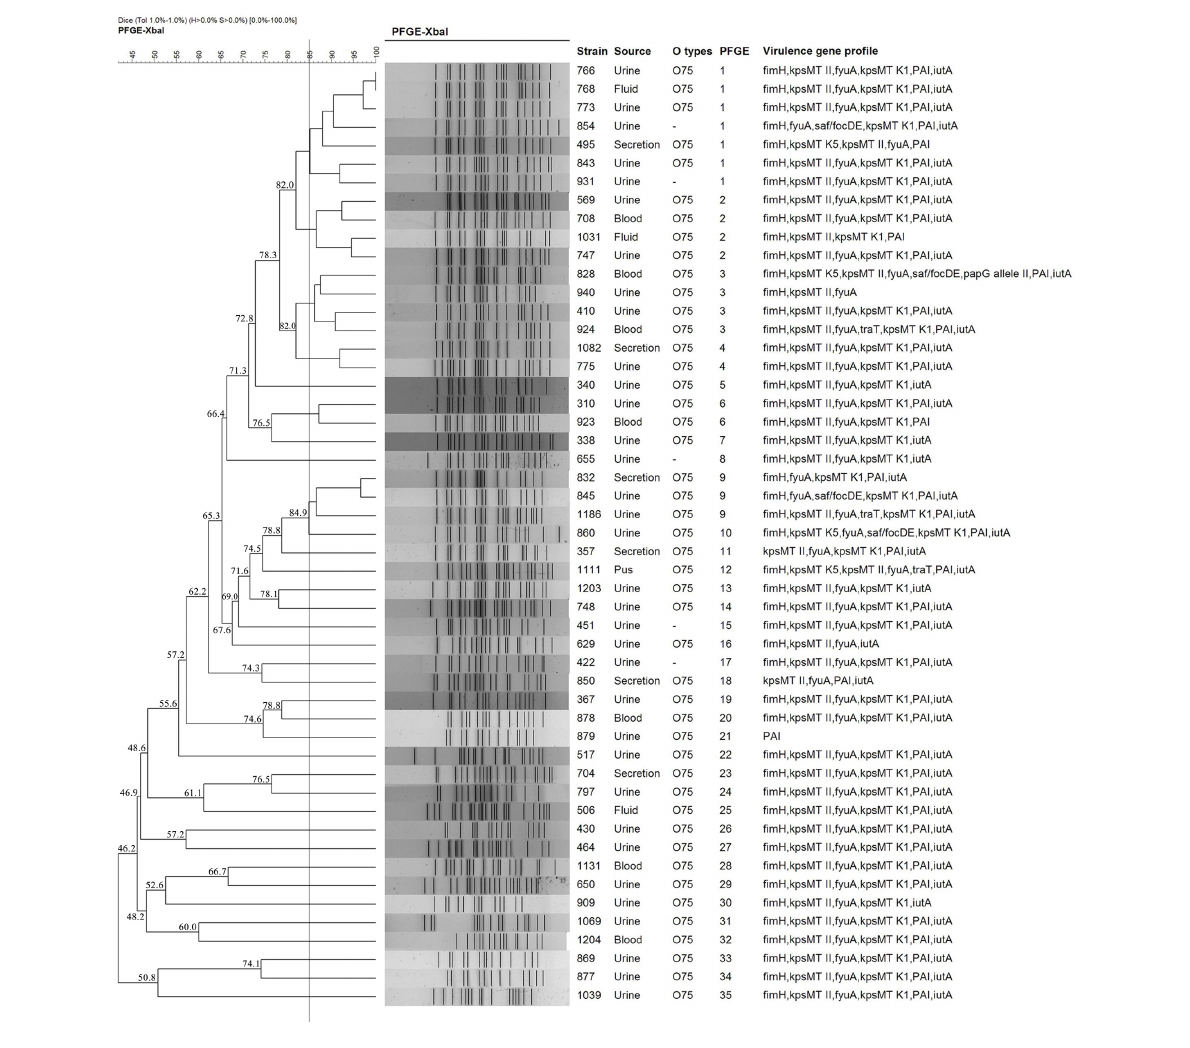
FIGURE 1 | Dendrogram of the PFGE patterns of chromosomal DNA restriction fragments from 51 ST1193 Escherichia coli isolates. The dendrogram was constructed using the UPGMA method. Dice coefficients (percentages) are listed in the scale on the top of the dendrogram. Strain number, sample source, O serotype, PFGE patterns and virulence factors (VFs) are